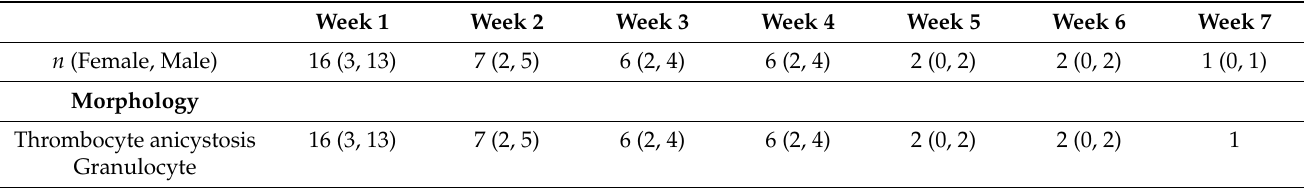
Table 4. Morphologies from 16 ICU patients with aberrant signals in